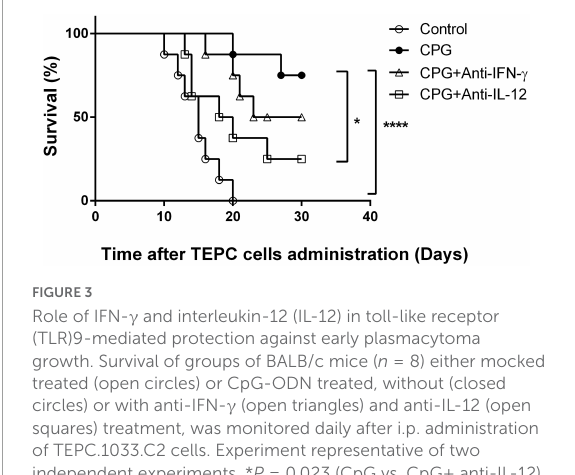
FIGURE3 Role of IFN- γ and interleukin-12 (IL-12) in toll-like receptor (TLR)9-mediated protection against early plasmacytoma growth. Survival of groups of BALB/c mice ( n = 8) either mocked treated (open circles) or CpG-ODN treated, without (closed circles) or with anti-IFN- γ (open triangles) and anti-IL-12 (open squares) treatment, was monitored daily after i.p. administration of TEPC.1033.C2 cells. Experiment representative of two independent experiments. * P = 0.023 (CpG vs. CpG+ anti-IL-12) and P = 0.24 (CpG vs. CpG+ anti-IFN- γ ) by Log-rank (Mantel–Cox) test. **** P ≤